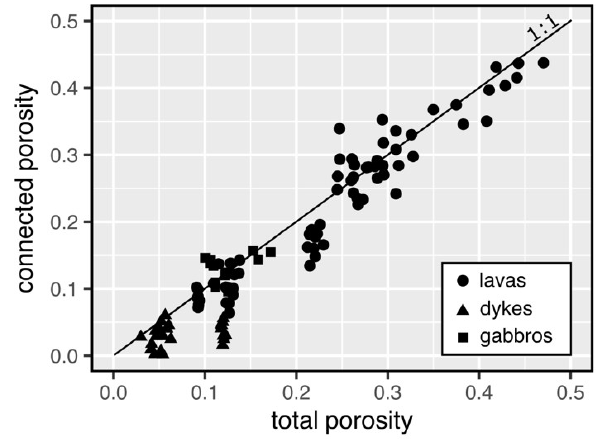
Figure 5: Connected porosity as a function of total porosity for the rocks from La Réunion (data available in Table A1). The 1:1 line (i.e. where total porosity equals connected porosity) is shown on the graph. “Dykes” cor- respond here to D1 and micro-troctolite